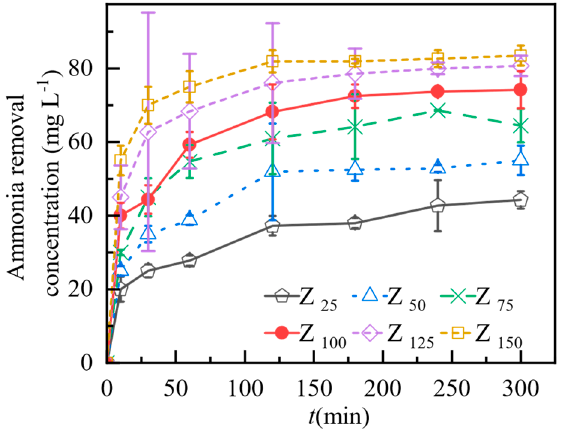
Figure 5. Nitrogen (N) adsorption curves of different applications of zeolite in a drainage ditch simulation. The ammonia N (NH 4+ -N) adsorption rate was measured over time with 25, 50, 75, 100, 125, or 150 g L − 1 zeolite.